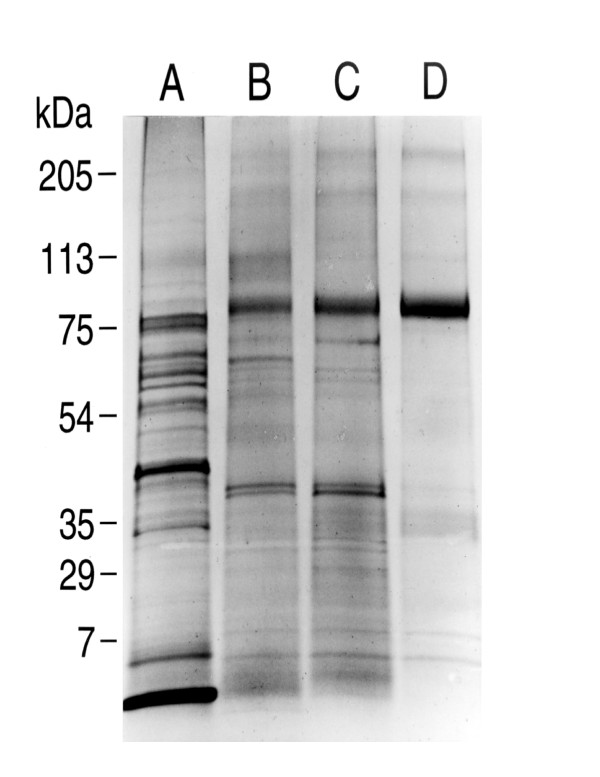
SDS-PAGE (4–20%) of solubilized barbel protein, visualized with silver stain, before (A) and after (B, C, D) each enrichment step. Each lane was loaded with 5 μg of protein. Lane A: Total protein of fraction Sp. Lane B: Galactose eluted protein from the RCA column containing L-Arg stimulated ion channel activity; Lane C: Protein of the first peak fractions of the Sephacryl gel filtration step containing L-Arg stimulated ion channel activity; and Lane D: Protein containing L-Arg stimulated ion channel activity from the ion exchange chromatography enrichment step.